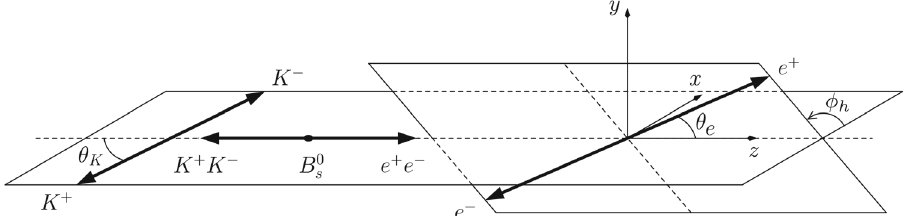
Fig. 1 Definition of the angles in the helicity basis. The polar angle θ K (θ e ) is the angle between the K + ( e + ) momentum and the direction opposite to the B 0 s momentum in the K + K − ( e + e − ) centre-of-mass system, and the φ h is the azimuthal angle between the K + K − and e + e − decay